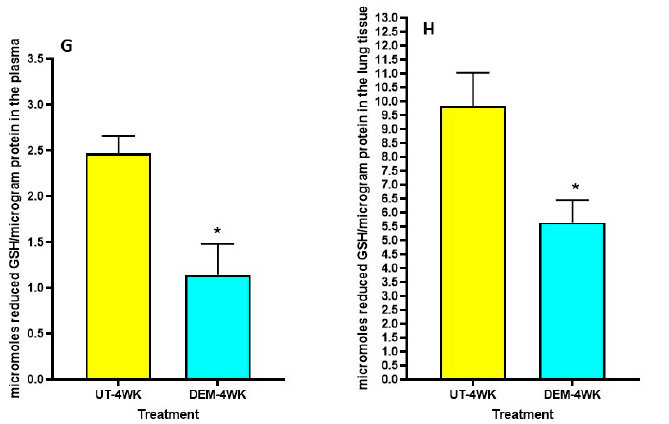
Figure 1. Measurement of total and reduced forms of glutathione in the lung lysates and plasma of M. tb infected mice that were sham-treated or treated with DEM. Total glutathione was measured in the plasma and lung lysates of M. tb infected mice at 2 weeks ( A , C ) and 4 weeks ( B , D ) post-infection. Reduced form of glutathione was also measured in the lung lysates and plasma of M. tb infected mice at 2 weeks ( E , F ) and 4 weeks ( G , H ) post-infection. Statistical analysis was performed using GraphPad Prism software. Unpaired t tests were performed using Welsch correction. All values reported represent the mean values for each respective category and a p -value of <0.05 was considered significant. Any placement of an asterisk (*) denotes a direct comparison of the DEM-treated versus untreated category. ** p -value < 0.005. The sample size ( n ) includes six mice each in the untreated and DEM-treated groups.